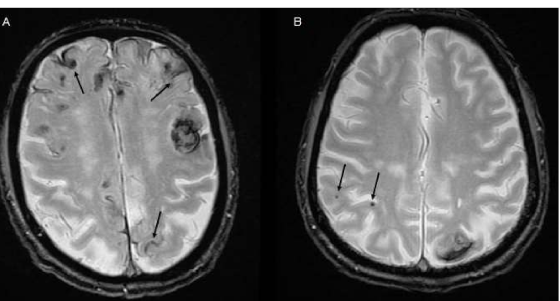
Figure 3. Small vessel disease markers. ( A ) MRI with evidence of lobar ICH and diffuse cor- tical superficial siderosis (arrows). ( B ) MRI with evidence of lobar ICH and lobar cerebral microbleeds